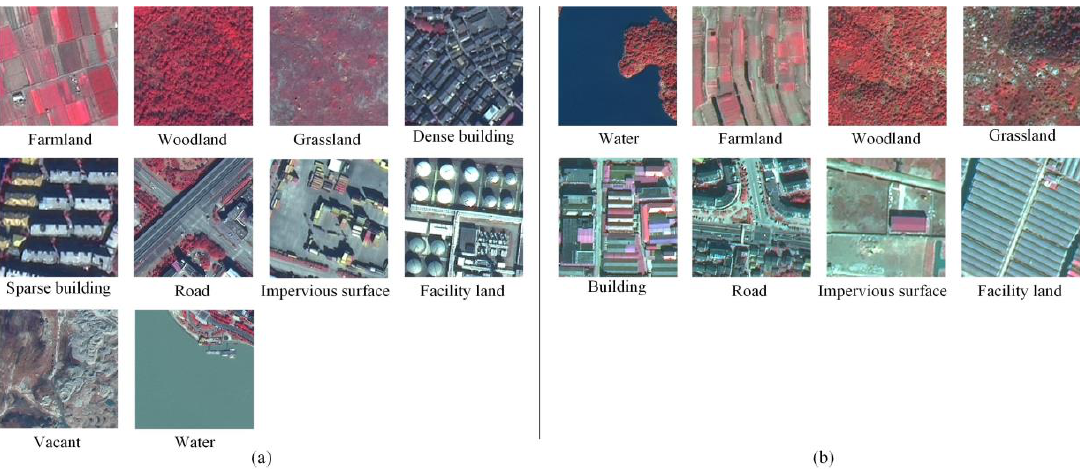
Figure 7. Examples of different land-cover classes in false-color for Beilun and Cixi datasets. ( a ) Images of 10 land-cover classes in the Beilun dataset. ( b ) Images of 8 land-cover classes in the Cixi dataset. Table 3. Land-cover classes, sample numbers, and subclass descriptions in the Beilun dataset. Class